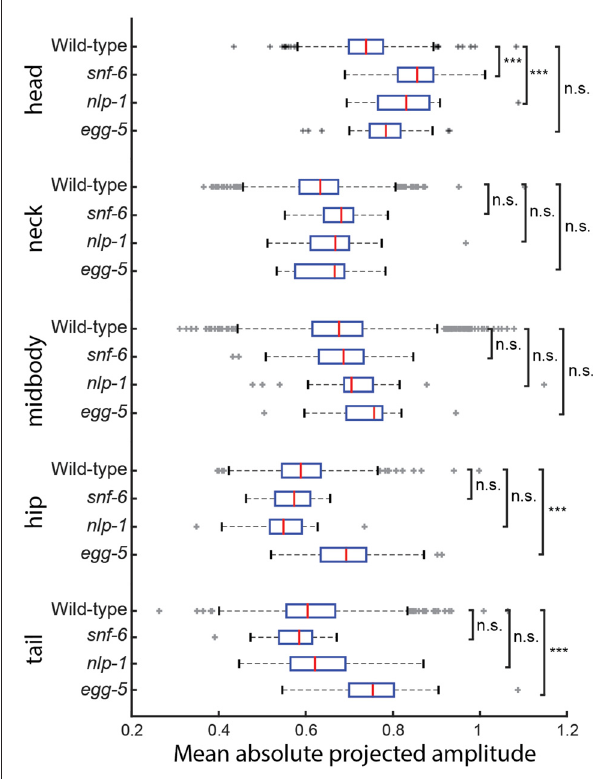
FIGURE 4 | The mean of the absolute projected amplitudes corresponding to each basis shape from NMF is taken for individual worms of four different genotypes. (wild type N2: n = 1303, snf-6 : n = 43, nlp-1 : n = 22, egg-5 : n = 23) snf-6 and nlp-1 worms have significantly increased head motion, but normal movement in the rest of their body in terms of magnitude ( p adj ( snf-6 ) = 3.13 × 10 − 14 , p adj ( nlp-1 ) = 6.83 × 10 − 4 ), while the opposite can be observed in egg-5 mutants ( p adj (hip) = 8.19 × 10 − 5 , p adj (tail) = 2.48 × 10 − 6 ). ∗∗∗ Indicates p <